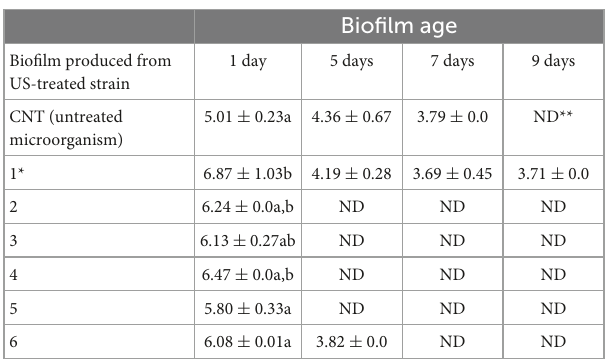
TABLE 3 Concentration of sessile cells (log CFU/cm 2 ) of B. longum subsp. infantis , preliminary treated through US.